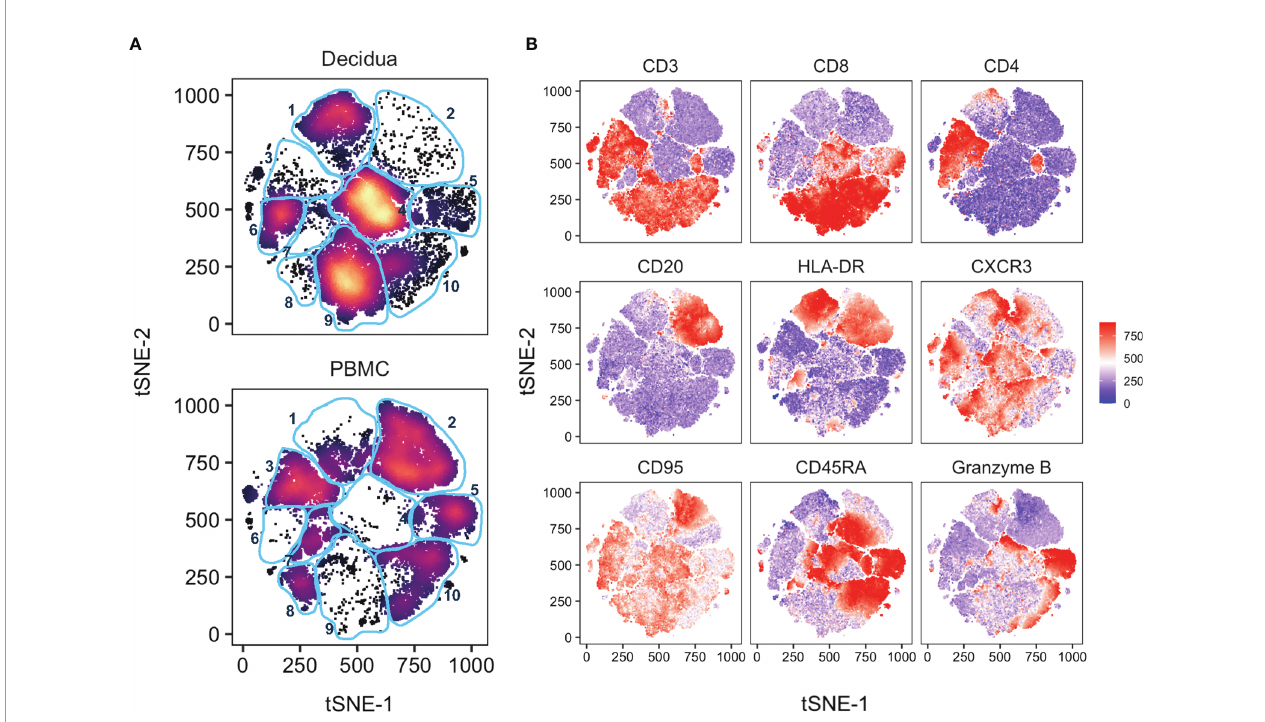
FIGURE 3 | tSNE analysis of PBMC and decidua in normal rhesus macaques. (A) tSNE plot representing an equal number of CD45+/live/single cell/leukocytes from decidua (n = 9) and PBMC (n = 24) of normal pregnant rhesus macaque samples. The 28-color adaptive panel was used to generate this plot. Blue gates were manually drawn based on clustering patterns. (B) Individual MFI gradients of nine markers on the tSNE map. Red coloring represents high MFI and blue coloring represents low MFI. Remaining gradients are found in Supplemental Figure 2